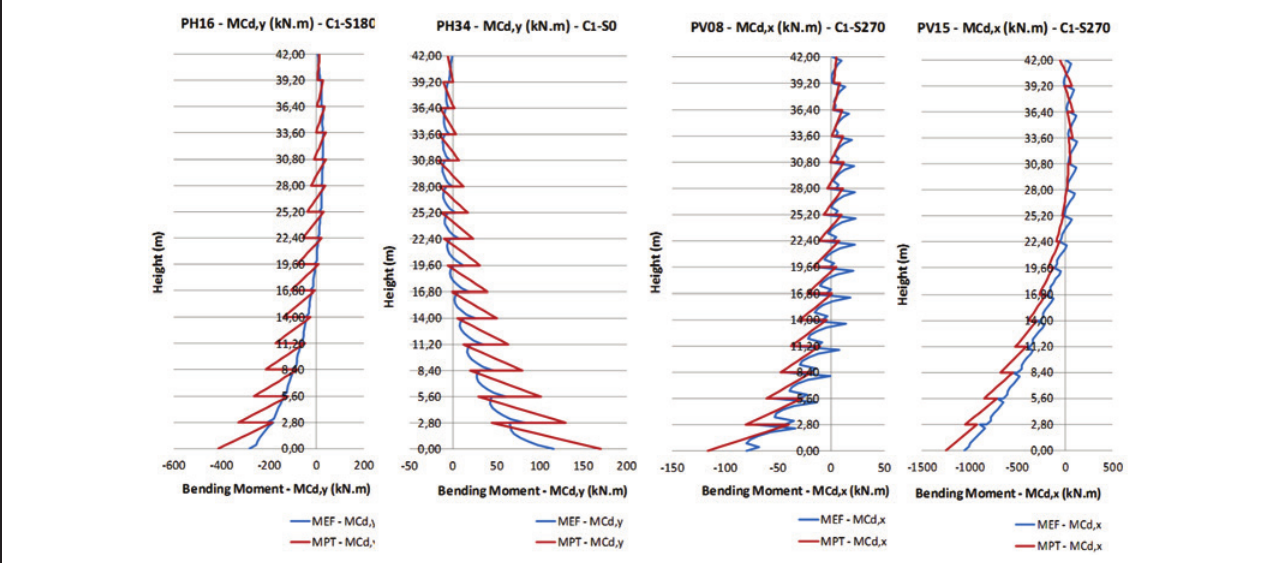
Figure 14 – Diagram of M of the walls PH16 and PH34 and M of the walls PV08 and PV15 Cd,y